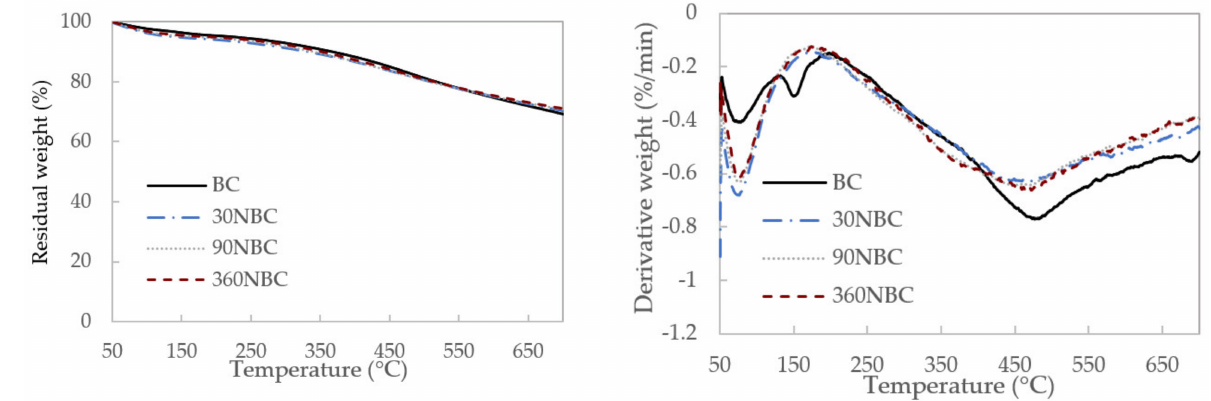
Figure 4. ( a ) The TGA and ( b ) DTG profiles of biochar (BC) and NBC samples.